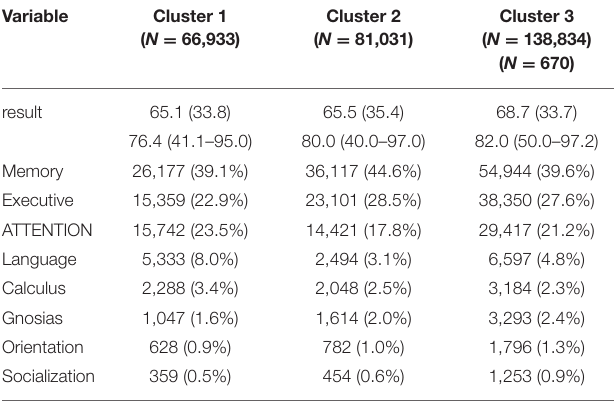
TABLE 8 | GNPT tasks executions by